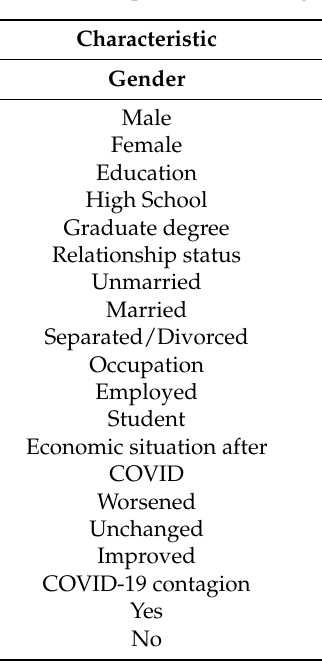
Table 1. Participants sociodemographics characteristics, ( n = 493).